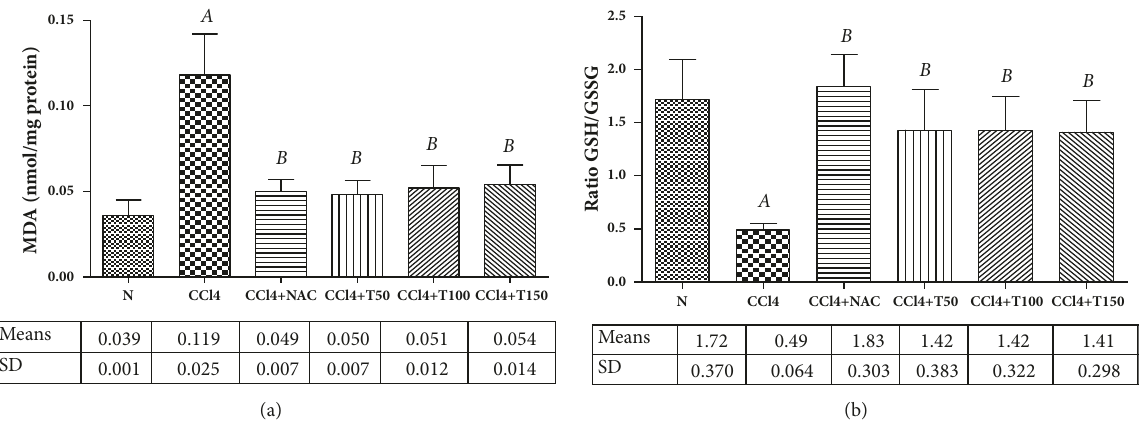
Figure 3: (a) Liver MDA levelsof normal control, CCl 4 , CCl 4+ NAC150, CCl 4+ T50, CCl 4+ T100,and CCl 4+ T150 groups. Data representthe means ± SD (n=5). N: normal, CCl 4 : carbon tetrachloride,NAC:N-acetylcysteine150 mg/kg body weight/day,and T50, T100, and T150: Proliverenol 50, 100, and 150 mg/kg body weight/day. A = p < 0.05 vs. N, B = p < 0.05 vs. CCl 4 ( 𝛼 =0.05). (b) Ratio GSH/GSSG of normal control, CCl 4 , CCl 4+ NAC150, CCl 4+ T50, CCl 4+ T100, and CCl 4+ T150 groups. Data represent the means ± SD (n=5). N: normal, CCl 4 : carbon tetrachloride, NAC: N-acetylcysteine 150 mg/kg body weight/day, and T50, T100, and T150: Proliverenol 50, 100, and 150 mg/kg body weight/day. A = p < 0.05 vs. N, B = p < 0.05 vs. CCl 4 ( 𝛼 =0.05).